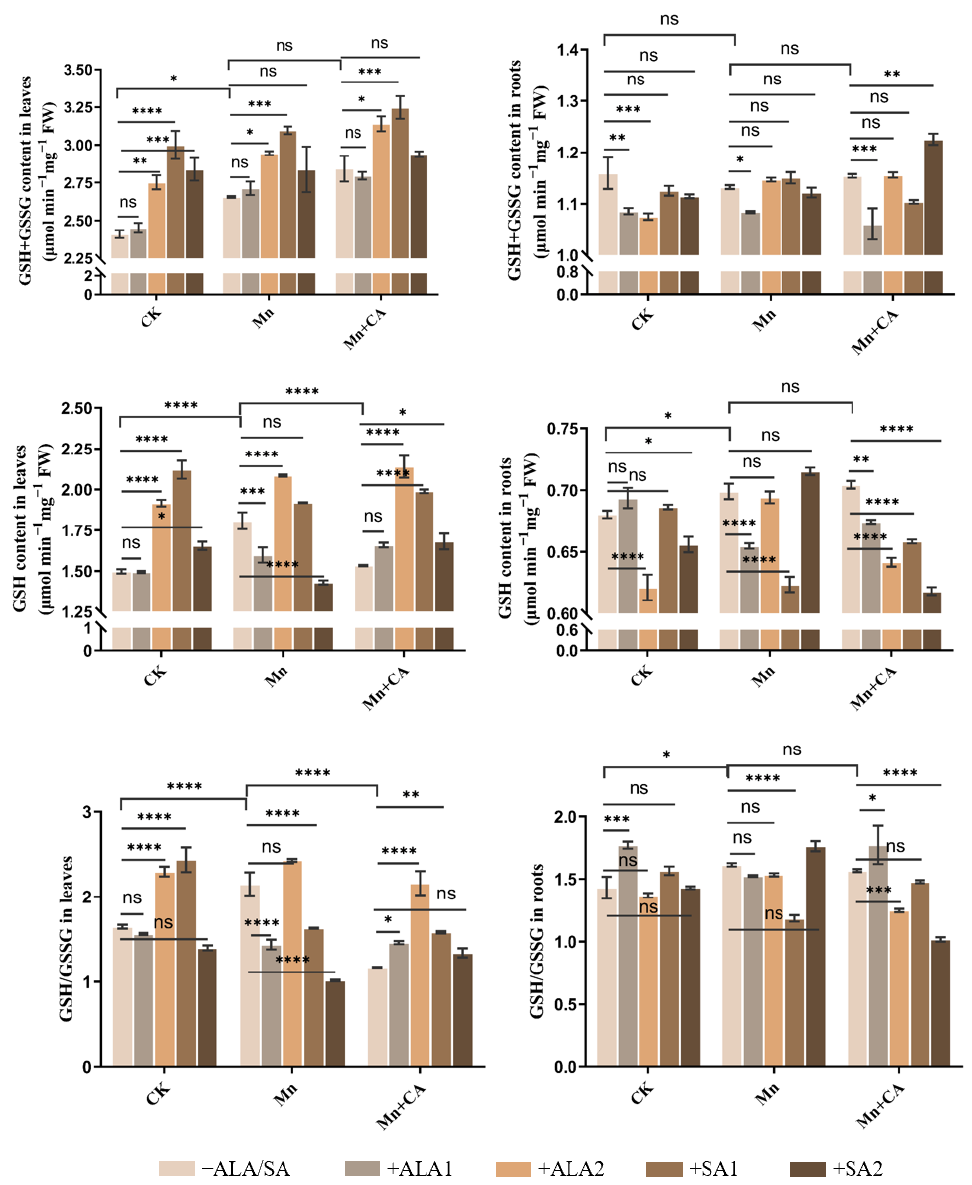
Figure 3. Effects of 5-aminolevulinic acid or salicylic acid (ALA/SA) combined with citric acid (CA) on total glutathione content (GSH + GSSG), glutathione reduced (GSH) and glutathione re- duced/glutathione oxidized (GSH/GSSG) ratio in the leaves and roots of manganese (Mn)-treated sunflower plants. CA means 20 mmol kg − 1 citric acid treatment. ALA1/ALA2 indicates spraying with 10/20 mg L − 1 ALA. SA1/SA2 indicates spraying with 50/100 mg L − 1 SA. CK, control plants without any treatment; Mn means that plants were exposed to 0.8 g kg − 1 Mn for 7 days; Mn + CA indicates plants treated with CA for 7 days after Mn treatment. Mn + CA + ALA/SA treatment indicates plants treated with ALA/SA for one week after CA treatment. Note: Data are the means of three replicates (mean ± SE). * indicates a significant difference at p -value < 0.05, ** p -value < 0.01, *** p -value < 0.001, **** p -value < 0.0001; ns indicates no significant difference according to Tukey’s multiple comparisons test.